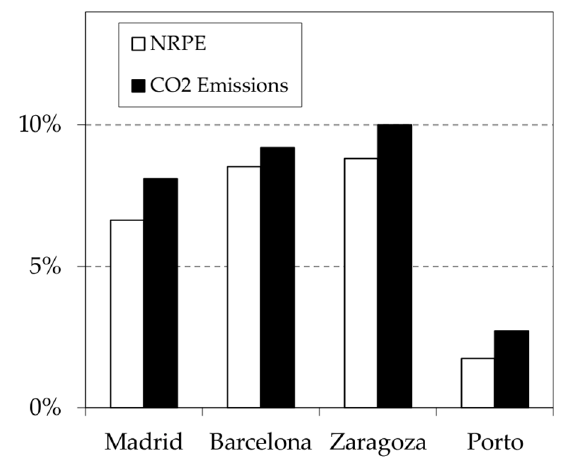
Figure 4. Energy savings of a WLHP system with respect to the 4-tube fan-coil water system, in terms of nonrenewable primary energy and CO 2 emissions in the four